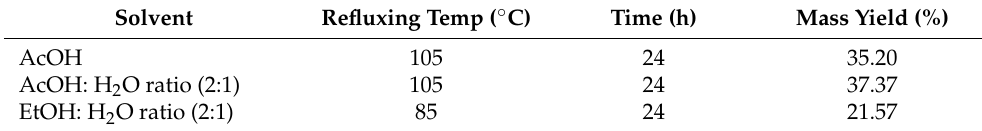
Table 2. The mass yields extracted and extraction conditions of AD-UHS using three